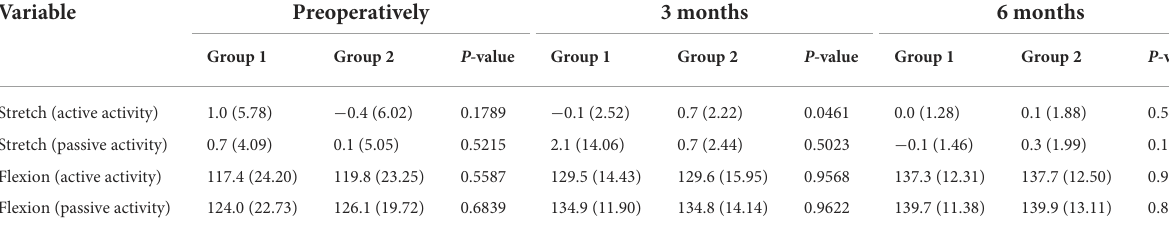
TABLE 8 Functional range of motion measurement.